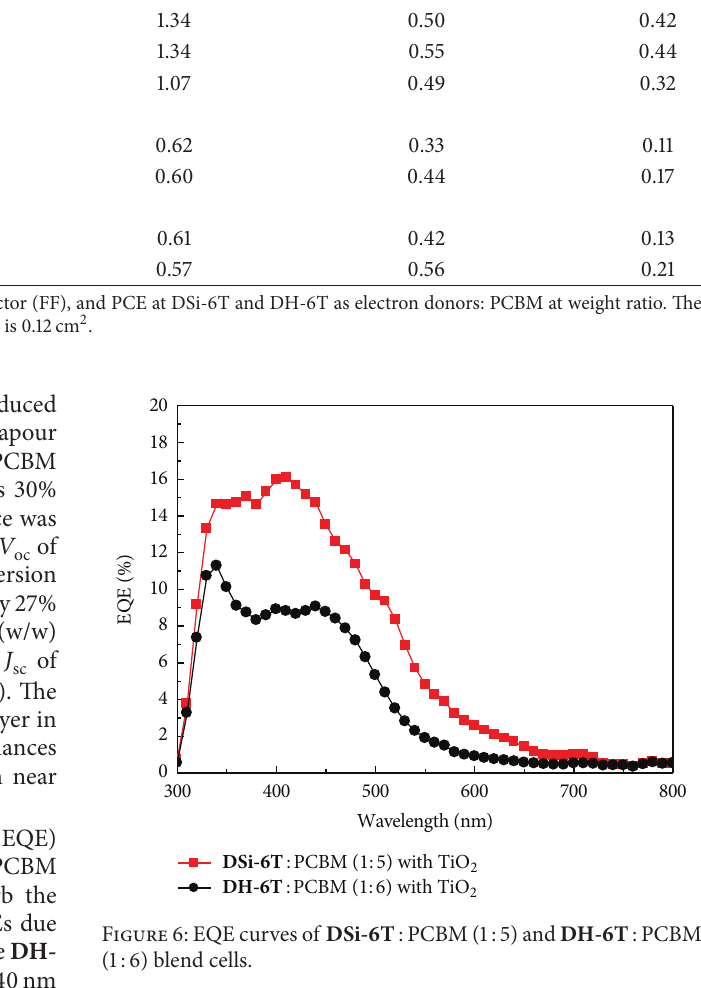
and 1 : 6 (w/w) for DSi-6T : PCBM and DH-6T : PCBM,